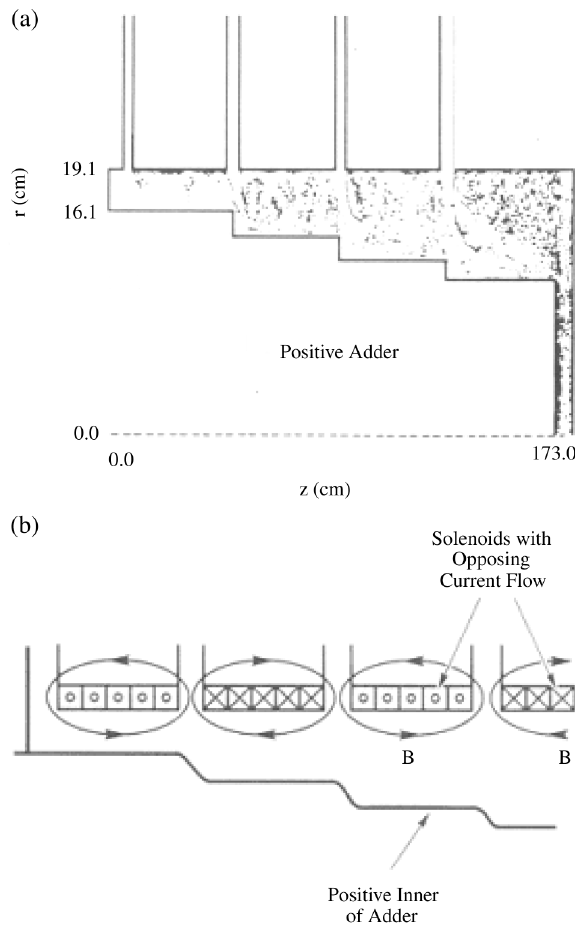
FIG. 20. (a) Distribution of sheath electrons for positive po- larity four-stage adders from particle-in-cell code simulations. (b). Sketch of a positive polarity induction voltage adder using alternating-sign magnetic fields to trap sheath electrons within each adder